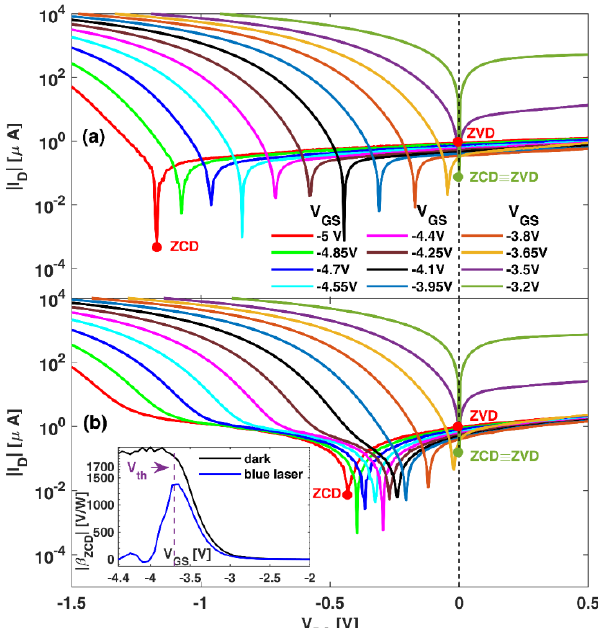
Figure 6. 𝐼 𝐷𝑙𝑒𝑎𝑘 and | I G |/2 at 𝑉 𝐷𝑆 = 0.1 V ( a ) as a function of 𝑉 𝐺𝑆 measured at different T for the case of the transistor with L g = 250 nm and ( b ) as a function of T for 𝑉 𝐺𝑆 = −4.5 V for the three transistors under test.